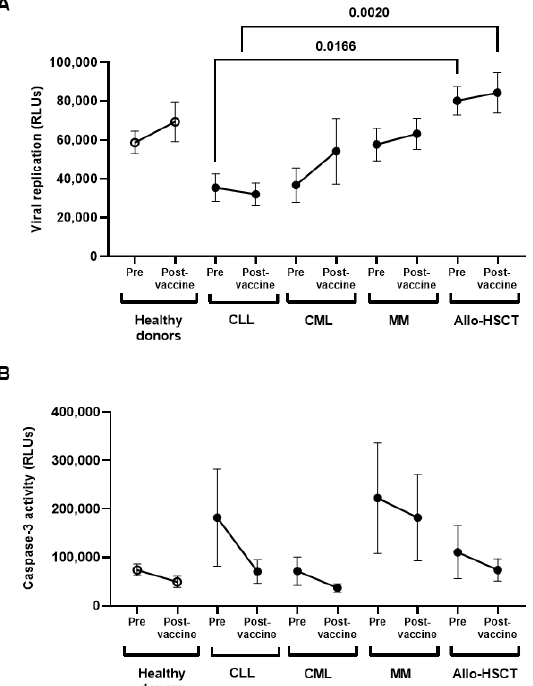
Figure 4. DCC and viral neutralization activity against SARS-CoV-2 infected cells of PBMCs of individuals with OHD before and after receiving one-dose vaccine. ( A ) The capacity of PBMCs from individuals with OHD to eliminate SARS-CoV-2-infected Vero E6 cells was determined by quantifying the production of Renilla (RLUs) after co-culture for 1 h. ( B ) DCC was assessed by measuring the activity of caspasa-3 in SARS-CoV-2-infected Vero E6 cells co-cultured with PBMCs from indi- viduals with OHD, in comparison with healthy donors. Each dot in the graphs corresponds to mean ± SEM. Statistical significance between groups was calculated using one-way ANOVA test.